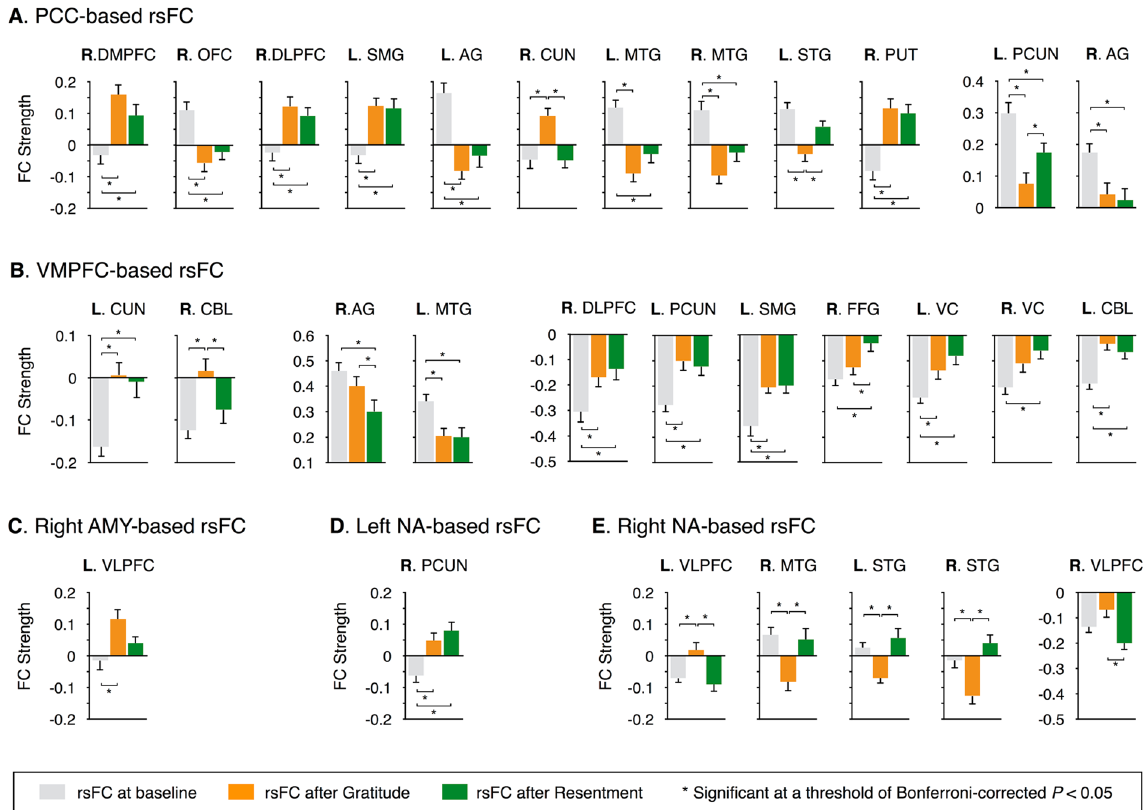
Figure 4. Significant seed-based resting-state functional connectivity (rsFC) and their post-hoc comparisons for ( A ) posterior cingulate cortex (PCC)-based rsFC, ( B ) ventromedial prefrontal cortex (VMPFC)-based rsFC, ( C ) right amygdala (AMY)-based rsFC, ( D ) left nucleus accumbens (NA)-based rsFC, and ( E ) right NA-based rsFC. Standard errors on bar graphs were plotted. The detailed descriptions for each cluster such as the center positions in the Montreal Neurological Institute coordinate, mean and standard deviation, cluster size, statistical value are summarized in Supplementary Table S6. Abbreviations: AG, angular gyrus; CBL, cerebellum; CUN, cuneus; DLPFC, dorsolateral prefrontal cortex; DMPFC, dorsomedial prefrontal cortex; FFG, fusiform gyrus; L, left; MTG, middle temporal gyrus; OFC, orbitofrontal gyrus; PCUN, precuneus; PUT, putamen; R, right; SMG, supramarginal gyrus; STG, superior temporal gyrus; VC, visual cortex; VLPFC, ventrolateral prefrontal